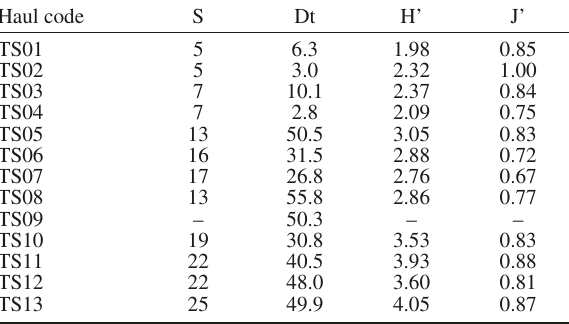
Table 3. – Species richness (S), total abundance (Dt, ind./100 m 2 ), Shannon-Wiener diversity index (H’, log ) and Pielou evenness (J’) 2 of the cumacean fauna sampled with a suprabenthic sledge at 13 stations on the southern margin of the Cap Ferret Canyon (values from nets N1-N4). –, no data.